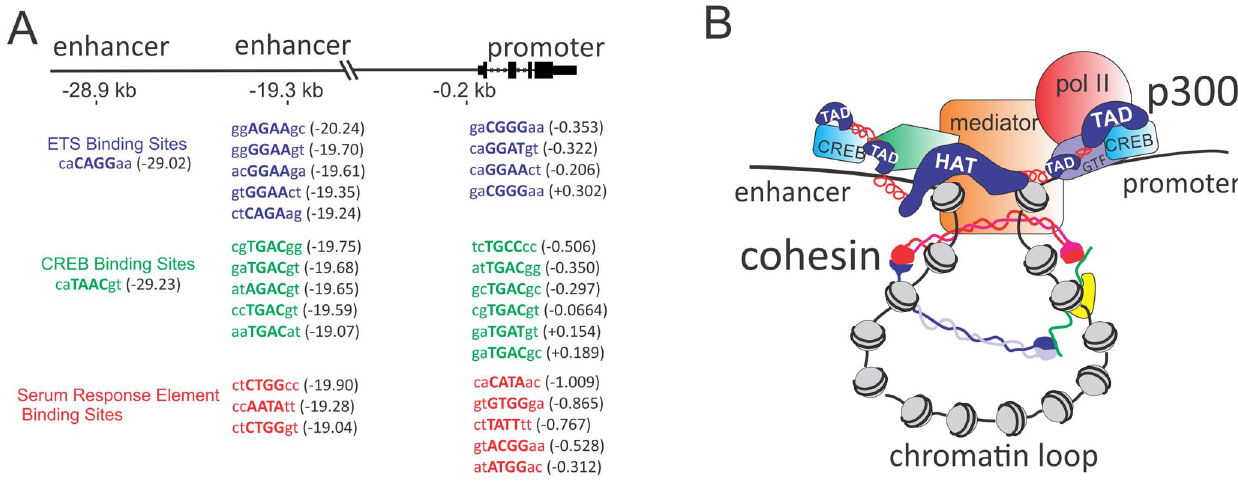
Figure 6. Role of p300 in stabilizing long-range promoter enhancer interactions. (A) Schematic table showing clusters of ETS, CREB, and SRE binding sites shared across enhancer and promoter elements at the FOS locus. (B) Schematic representation of possible interaction between p300, Mediator, Cohesin and bound general and sequence specific transcription factors.